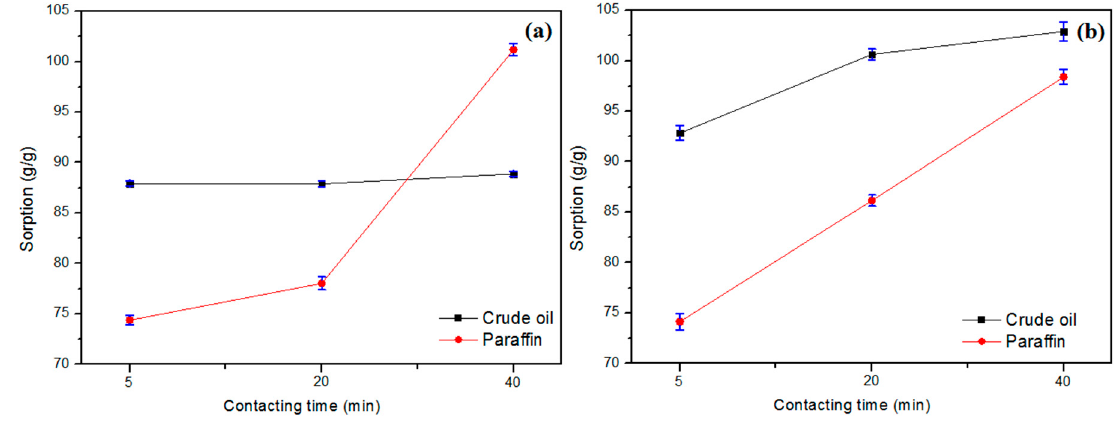
Figure 6. Short-time sorption tests for system ( a ) oil only and ( b ) oil/water, for petroleum and paraffin. The data from the present study indicate that the fiber treated by combining NaOH and heat treatment (CPNaOHT) showed an increase in petroleum sorption capacity of 150% and 74% for paraffin when compared to CP fiber in nature. The treated fiber had a higher sorption capacity than CPT150 (thermal treatment at 150 ◦ C), CPT200 (thermal treatment at 200 ◦ C), CPNaOH (treated with NaOH), CPNaClO 2 (treated with NaClO 2 ), and CPHT (treated with hydrothermal) fibers, previously studied by Hilário et al. (2019) and Anjos et al. (2020), suggesting that the new treatment process significantly improved the sorption capacity of the fibers and could be used as an efficient sorbent for the removal of spilled oil in both aquatic and terrestrial environments [14,15]. Figure 7 represents the sorption process of CPNaOHT fiber in the O/W system, using diesel oil (Density at 25 ◦ C, 0.813 g/cm 3 and viscosity at 25 ◦ C, 1.95 cP), also showing that the fiber has good sorption capacity for diesel (Figure 7b–d) and good buoyancy in water (Figure 7a) (A video file of the CPNaOHT fiber sorption test with diesel oil was provided in Supplementary